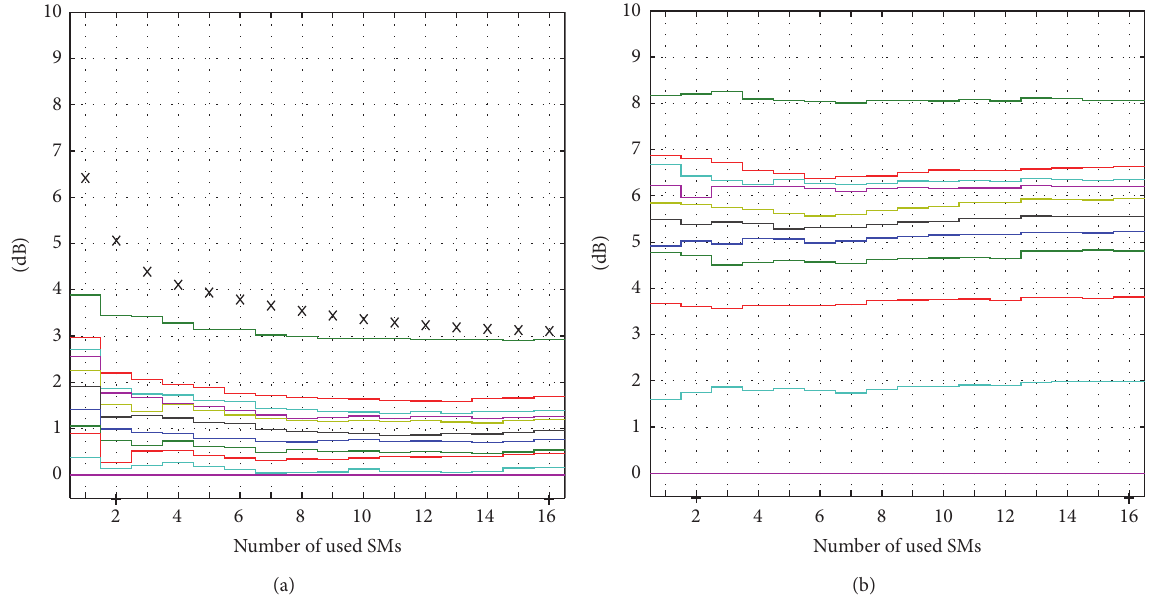
Figure 1: Noise eigenspectrum in measurement C1W (one transmitter and reflector; see Table 1). (b) With spatial calibration using a decoupling matrix and (a) without calibration. dB scale. See Section 3.3 for “SM.” See Section 3.5 for an explanation of the